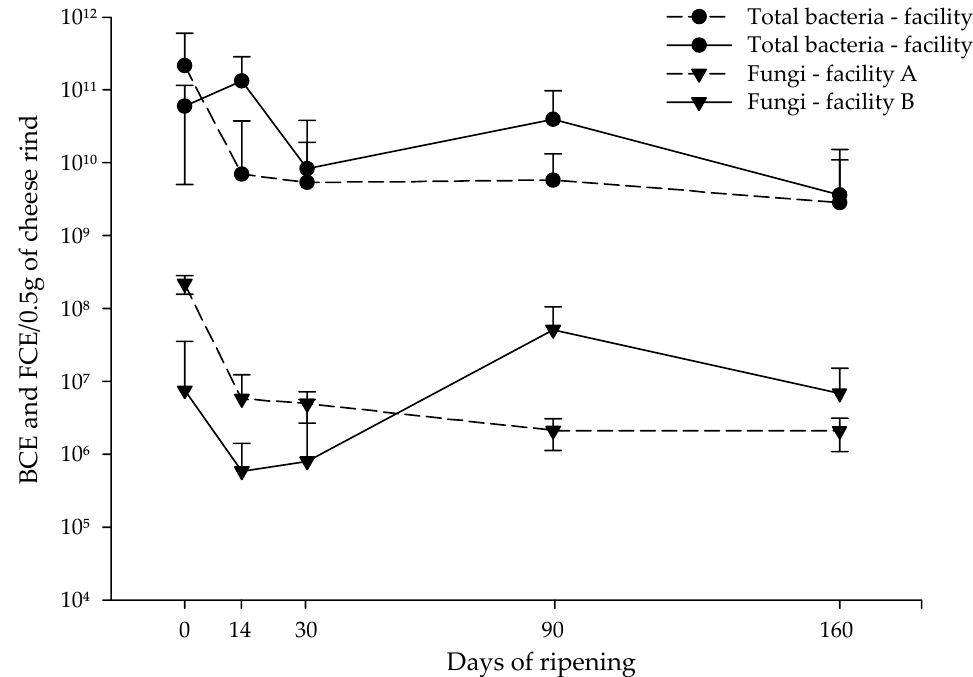
Figure 1. Abundance of cheese rind bacteria and fungi during ripening of Vorarlberger Bergkäse in two different cheese production facilities determined by qPCR. Bacterial cell equivalents (BCE) and fungal cell equivalents (FCEs) per 0.5g cheese rind during ripening in two different cheese production facilities are shown. The graph shows median and interquartile ranges for the 20 samples from each analyzed day of ripening (0, 14, 30, 90, and 160days) for each facility (A, B). The data for total bacteria count (BCE) was taken from Schmitz-Esser, et al. [16]. Numerical FCE values are shown in Table S3, p -values are shown in Table S4. Detailed information about 18S rRNA gene qPCR assay are listed in Table S1 (MIQE guidelines